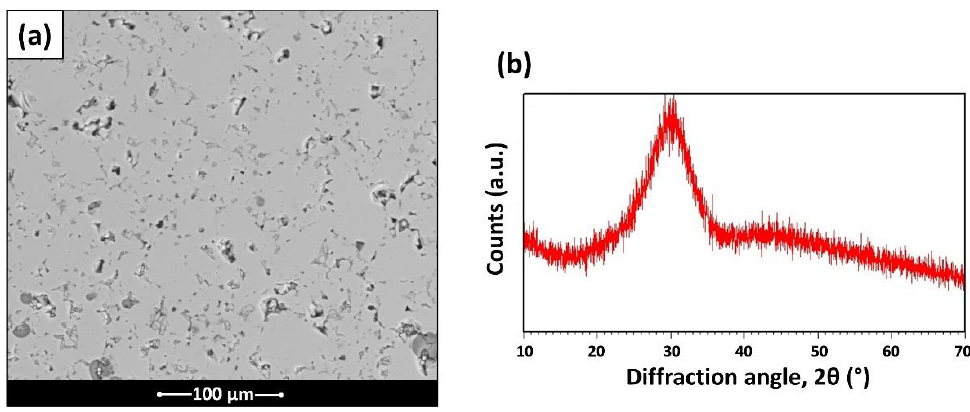
Figure 2. Sintered BGMS_LS: ( a ) cross section and ( b ) XRD diffractogram.